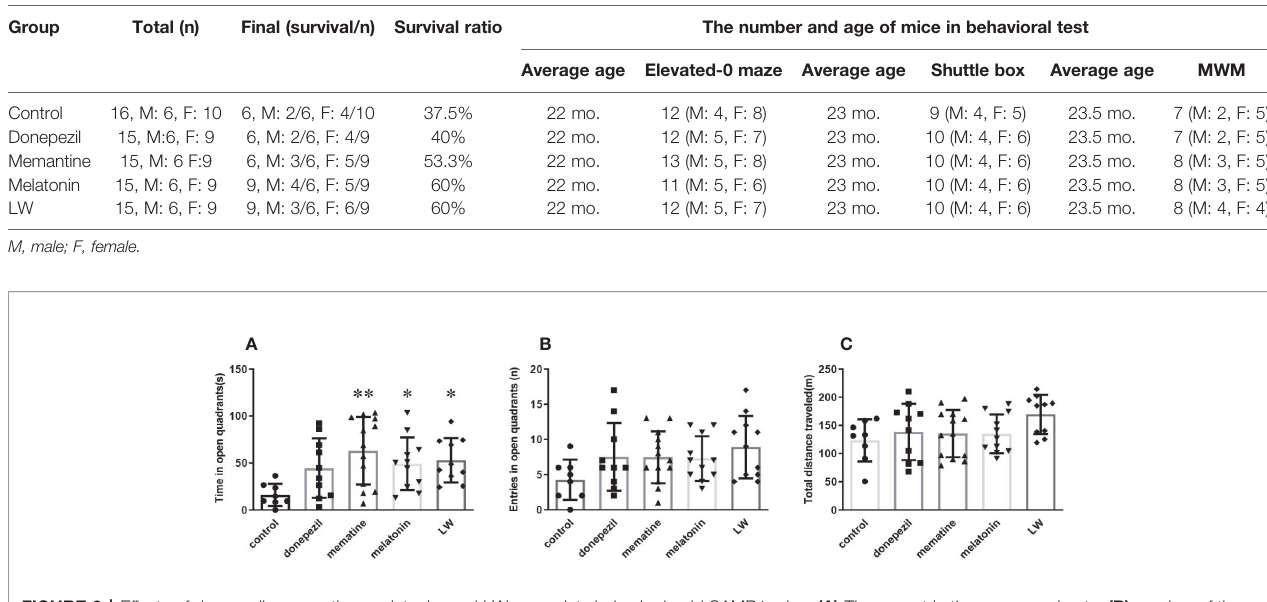
FIGURE 2 | Effects of donepezil, memantine, melatonin, and LW on anxiety behavior in old SAMR1 mice. (A) Time spent in the open quadrants, (B) number of the open quadrants entries, and (C) total distance traveled in the elevated zero maze test. * P < 0.05, ** P < 0.01 vs control group. Kruskal-Wallis test, mean ± S.D., n=11~13(male: n = 4~5, female: n =